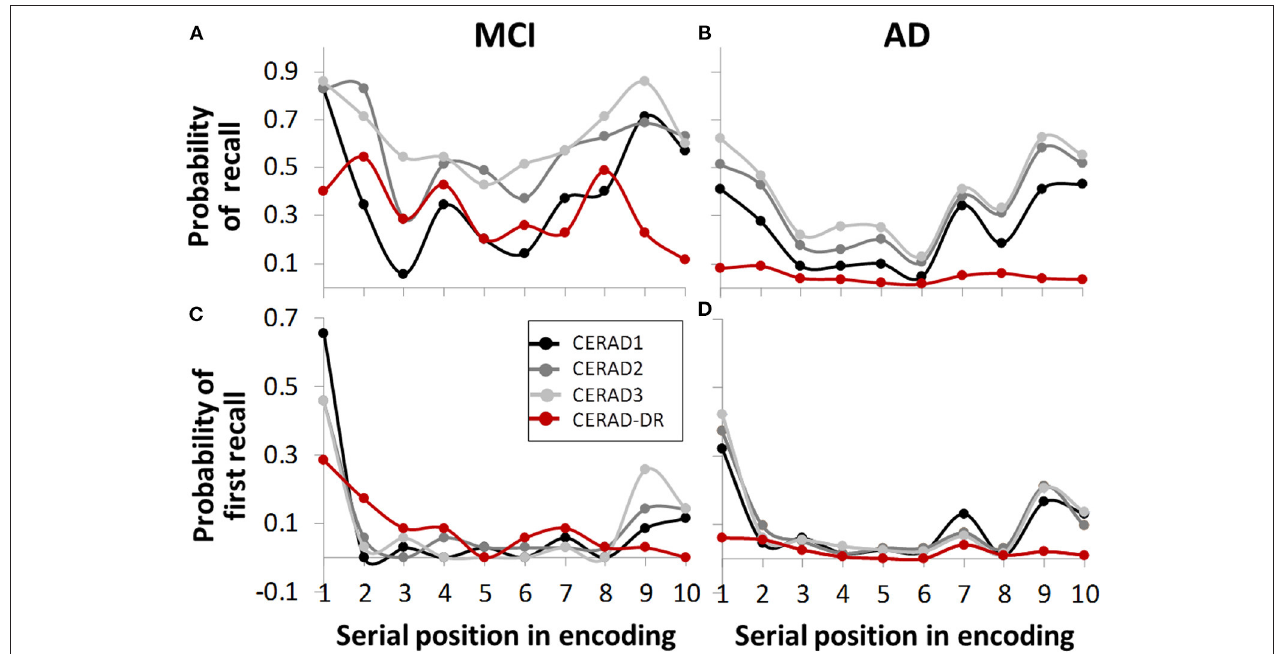
FIGURE 1 | Serial position curve, representing retrieval chances as a function of serial position in the wordlist during encoding. Graphs (A,B) show overall probabilities, (C,D) show probabilities for first word recalled. In immediate recall (CERAD 1, 2, 3, gray-scale graph lines), both groups showed primacy and recency effects in both overall probability (A,B) and first word recalled (C,D) . In delayed recall (CERAD-DR, red), none of the groups showed recency effect (C,D) , as expected. In contrast, there is a seemingly considerable reduction in the dementia group in primacy effect during delayed recall, as compared to other learning trials (D) , which is less evident in the MCI group (C) .